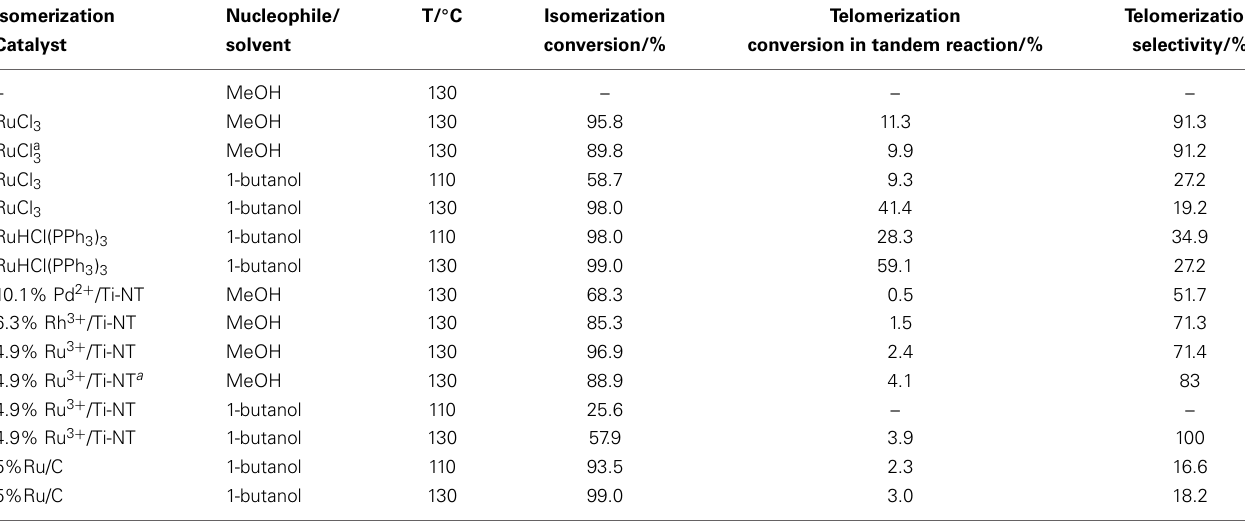
Table 1 | Tandem isomerization—telomerization of 1,4-pentadiene catalyzed by different isomerization catalysts and Pd(IMes)(dvds) as the telomerization catalyst.